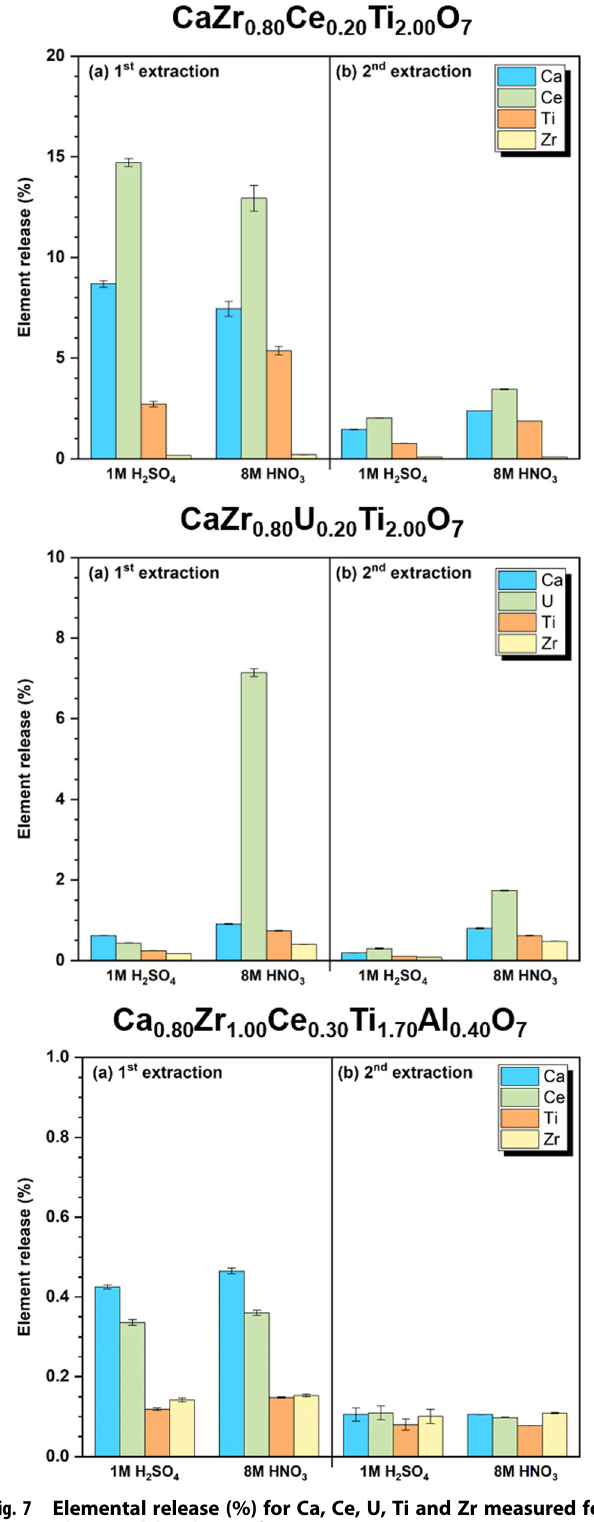
Fig. 7 Elemental release (%) for Ca, Ce, U, Ti and Zr measured for fi rst and second leaching of CaZr 0.80 Ce 0.20 Ti 2.00 O 7 , CaZr 0.80 U 0.20 - Ti 2.00 O 7 and reformulated Ca 0.80 Zr 0.90 Ce 0.30 Ti 1.60 Al 0.40 O 7 in 1M H 2 SO 4 and 8M HNO 3 , determined by ICP-OES analysis. Error bars represent the standard deviation of duplicate